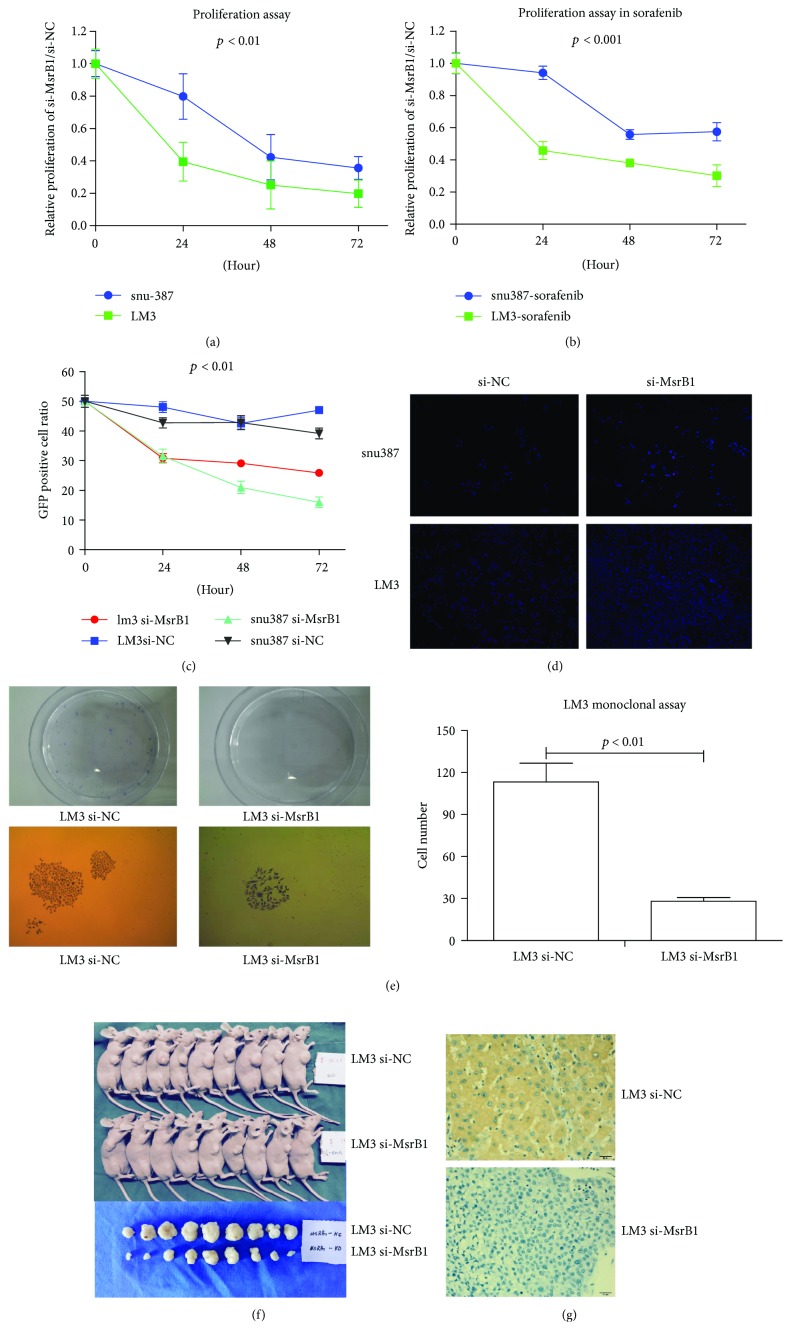
MsrB1 inhibits HCC cell proliferation in vitro and in vivo. (a) The MTT assay showed that MsrB1 knockdown inhibits the proliferation of LM3 and snu387 cells in 24, 48, and 72 h (P < 0.01). (b) The MTT assay showed that MsrB1 knockdown inhibits the proliferation of LM3 and snu387 cells in 24, 48, and 72 h under stress of sorafenib (P < 0.001). (c) Flow cytometry showed that MsrB1 knockdown inhibits the proliferation rate of HCC cells. (d) The EdU assay showed that the proliferation percentage of red-fluorescent cells was lower than that of control cells. (e) MsrB1 knockdown inhibits the colony formation of HCC cells. (f) MsrB1 knockdown inhibits the tumor volumes of the subcutaneous tumor of the two groups in 7 weeks in LM3 cells. (g) The expression of MsrB1 in the tumors of both groups of mice was shown to be much lower in the sh-MsrB1 group than in the sh-NC group.